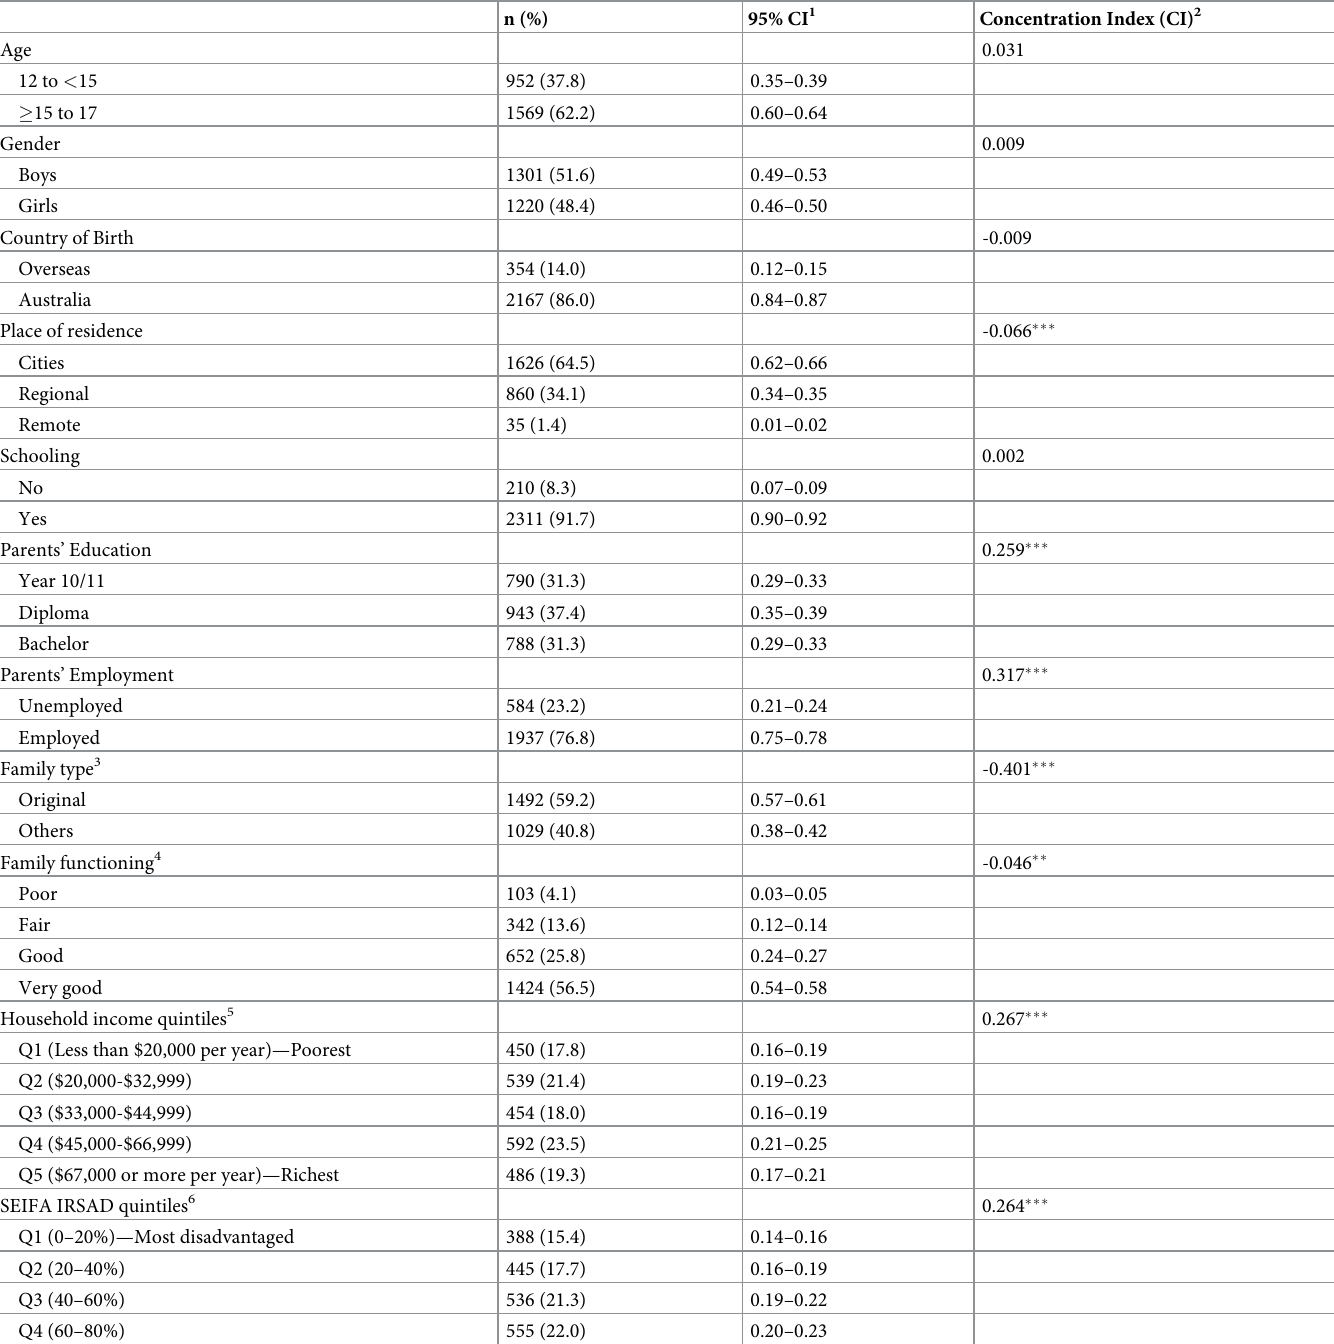
Table 1. Sample characteristics (n =